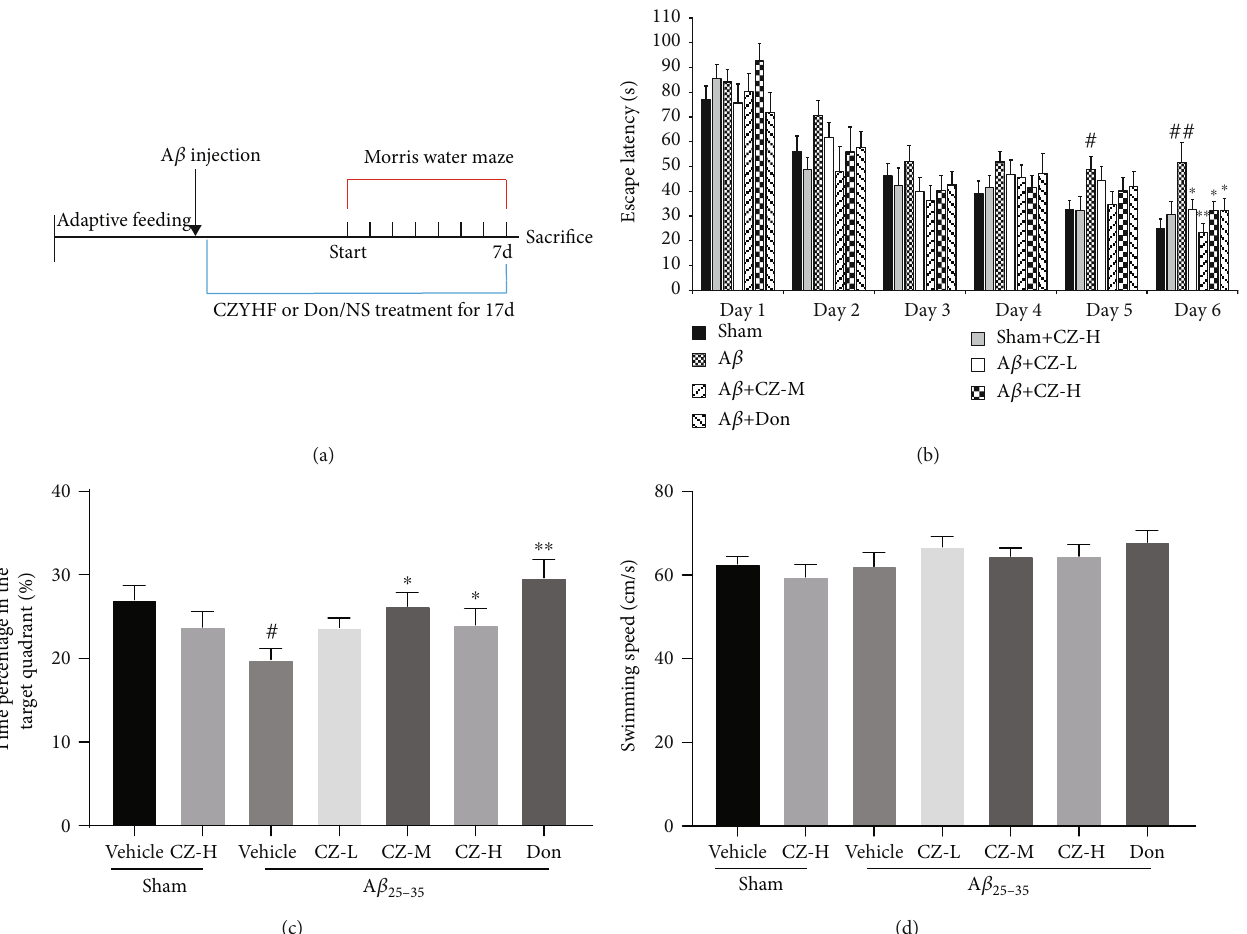
Figure 1: CZYH alleviates learning and memory impairments in A β percentage spent in target quadrant; (d) swimming speed. Data are means ± SEM , n = 12 ‐ 14 . # P < 0 : 05 and ## P < 0 : 01 vs. sham; ∗ P < 0 : 05 and ∗∗ P < 0 : 01 vs. A β 25-35